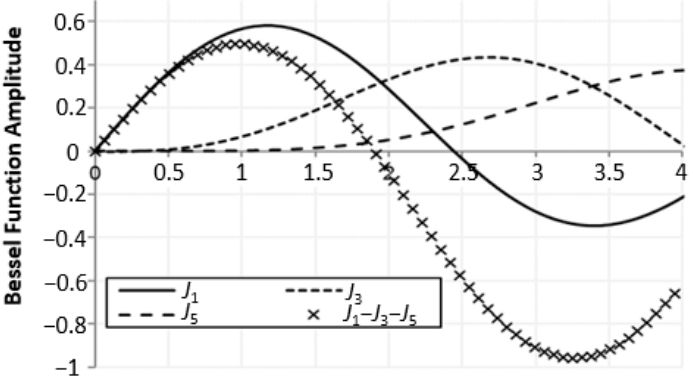
Figure 4. Bessel functions of the first kind.